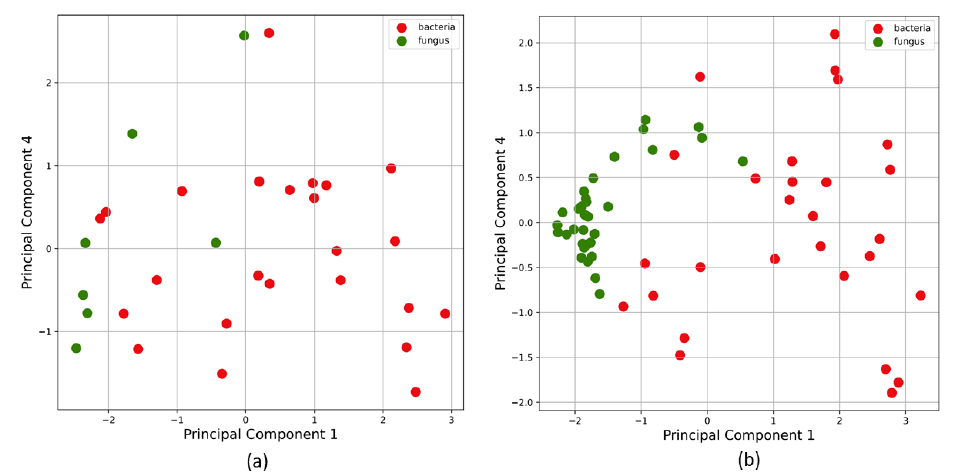
Figure 5. Principal component analysis on ( a ) original VOC data, and on ( b ) the dataset after SMOTE upsampling. SMOTE is a dataset upsampling technique that was used in this study to add artificial datapoints generated via random convex combinations of existing data points in the feature